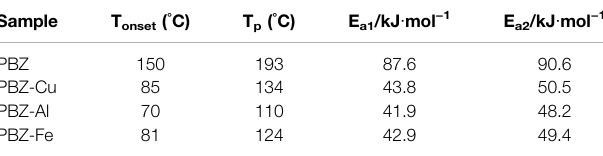
TABLE 2 | Curing parameters of benzoxazine monomers from non-isothermal DSC experiments.